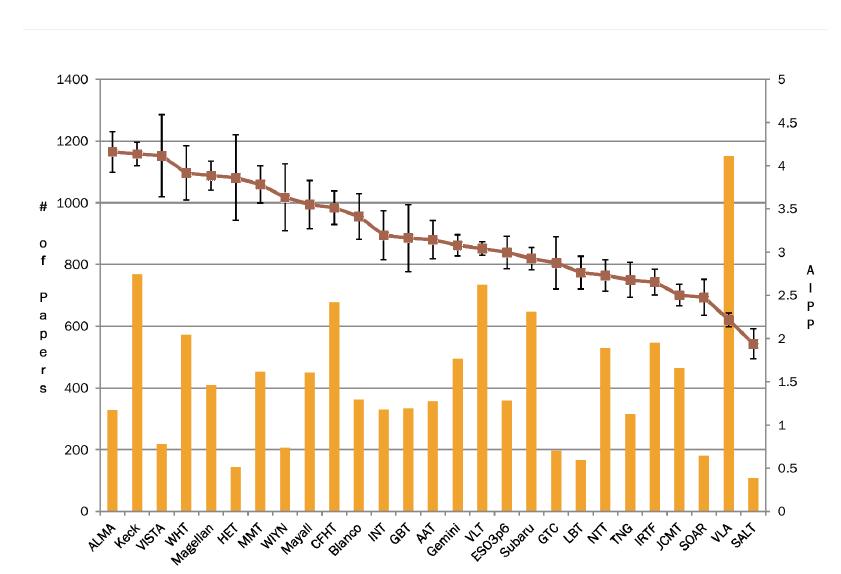
Figure 4. Average impact per paper and the number of papers by observatory